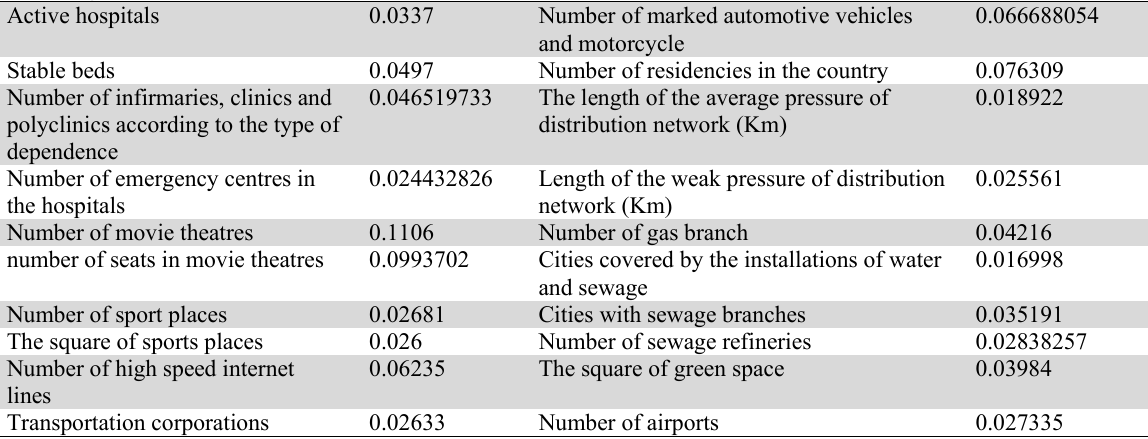
The weights of the indicators Active hospitals